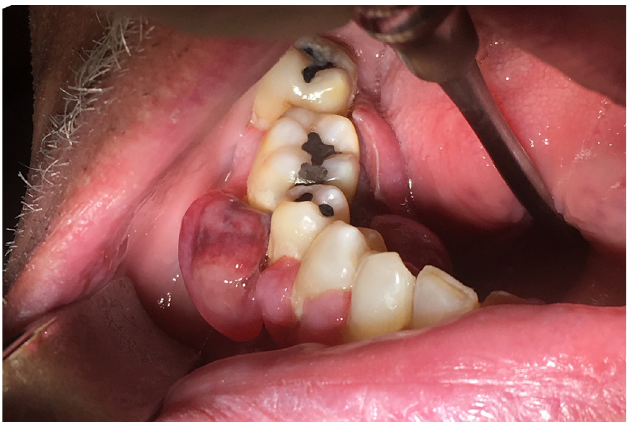
Fig. 1. Intraoral picture: vestibular and lingual gingival hypertrophy ranging from 44 to 47.